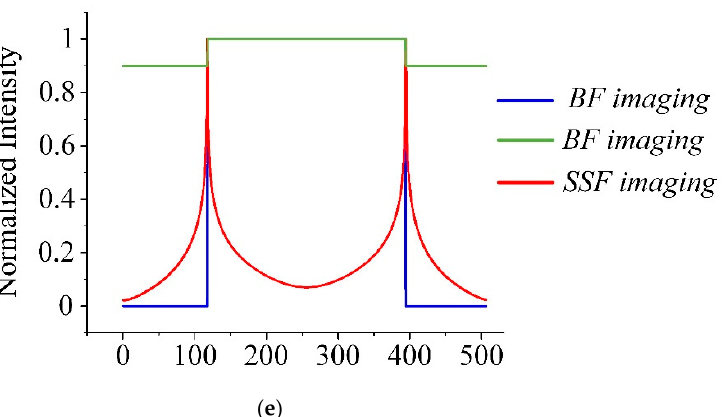
Figure 2. THz spiral spatial filtering imaging results of the simulated circular objects. ( a , c ) The circular objects with different image contrasts of 100 and 5.26%. ( b , d ) The corresponding edge detection results of the outline profiles. ( e ) The intensity distributions through the object/edge-enhanced images (blue, green, and red dashed lines).